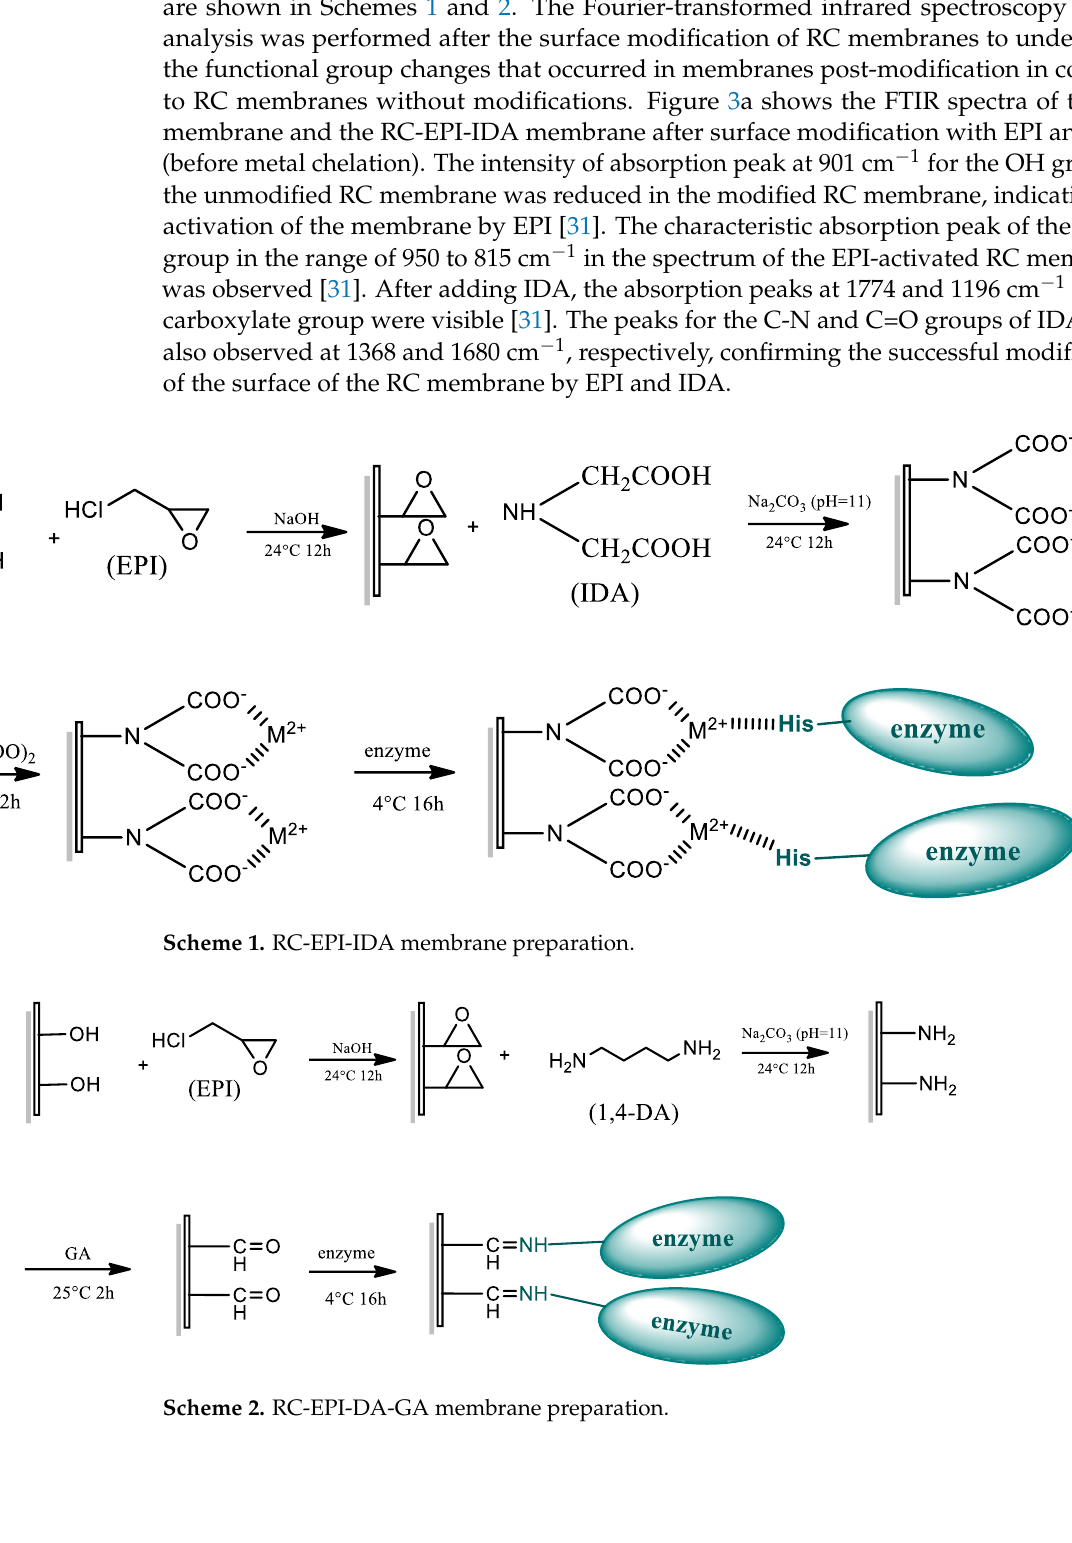
( b ) Figure 3. FTIR characterization of ( a ) RC-EPI-IDA membrane and ( b ) RC-EPI-DA-GA membrane. Figure 3b shows the FTIR spectra of the RC membrane and the RC-EPI-DA-GA mem- brane after surface modification with 1,4-DA and GA. Modification by 1,4-DA was con- firmed by the presence of an absorption band at 1602 cm −1 , corresponding to N-H bending in 1,4-DA [32]. A peak at 1720 cm −1 , representing the free aldehyde group of GA, con- firmed the successful membrane activation by GA [33]. 2.4. Metal Ion Selection for IMAM Chelation and Effect on Enzyme Activity In order to couple metal ions with the modified membrane RC-EPI-IDA, first, the effect of metal ions on the activity of free enzyme CelA must be determined. Therefore, the effect of various metal ions, viz., Zn 2+, Al 3+, Cu 2+ , Ni 2+ Fe 3+ , Mn 2+ , and Co 2+ , on the activity of free CelA enzymes was studied. The initial activity of the free enzymes was 1.25 U/mL, which was taken as control (100%). The Zn 2+ , Al 3+ , Cu 2+ , and Ni 2+ metal ion solutions ex- hibited an inhibitory effect on the endoglucanase activity. However, the CelA endoglu- canase activity was improved in the Fe 3+ , Mn 2+ , and Co 2+ metal ion solutions (Figure S2). Metal ions facilitate the binding of enzymes to the substrate to enhance enzymatic action by activating electrophiles or nucleophiles via electron transfer reactions. Metal ions may also help in maintaining three-dimensional active confirmation by bringing the enzymes